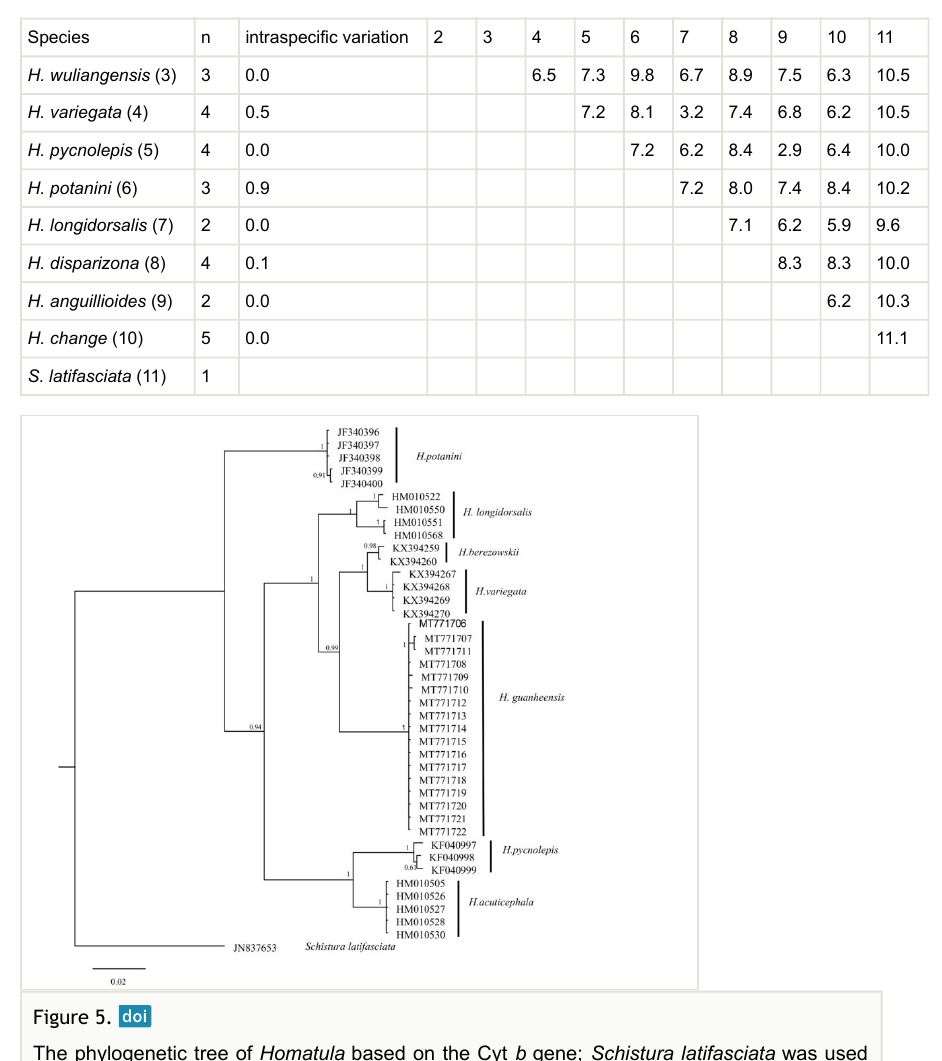
The phylogenetic tree of Homatula based on the Cyt b gene; Schistura latifasciata was used as the outgroup.